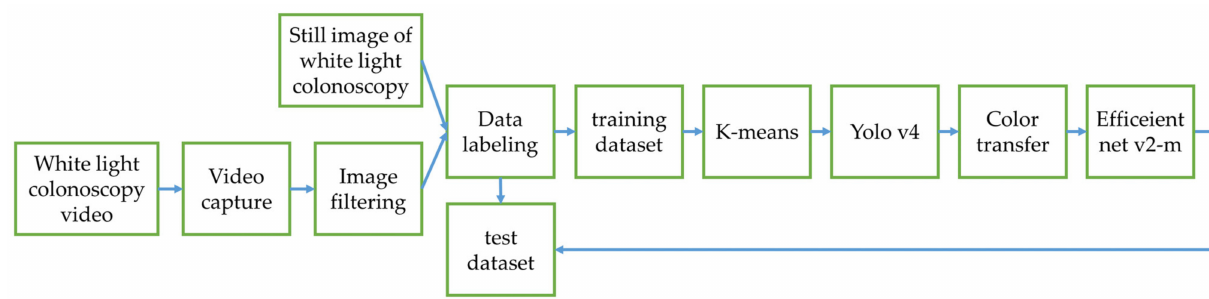
Figure 10. Experimental Design 1.